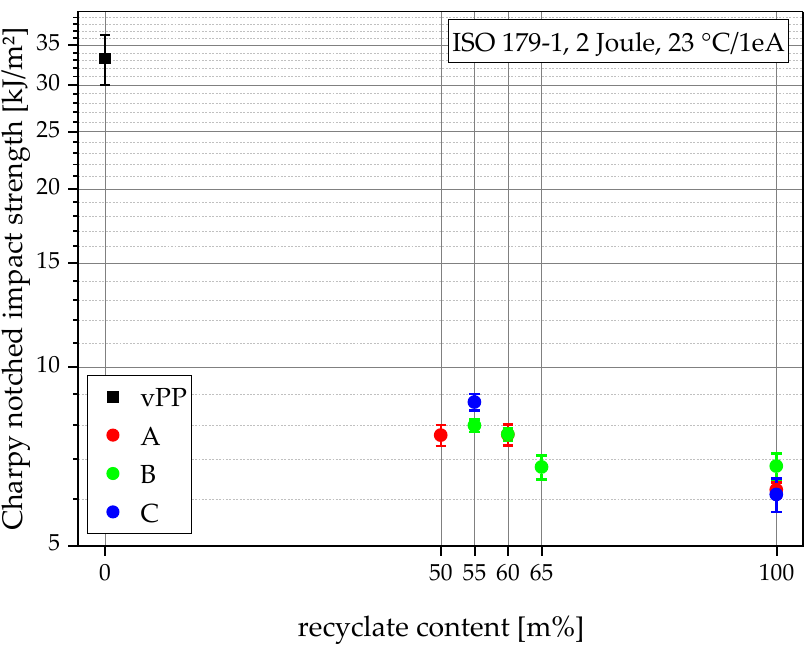
Figure 7. Graphical illustration of Charpy notched impact strengths of all materials.